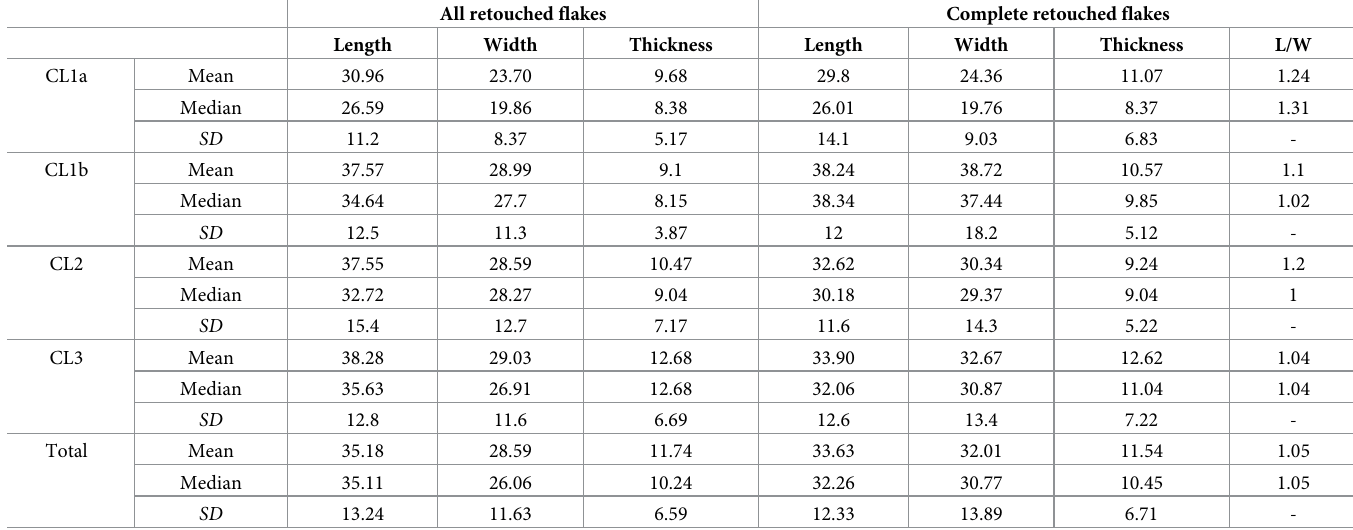
Table 4. Measurements of tools (mm).